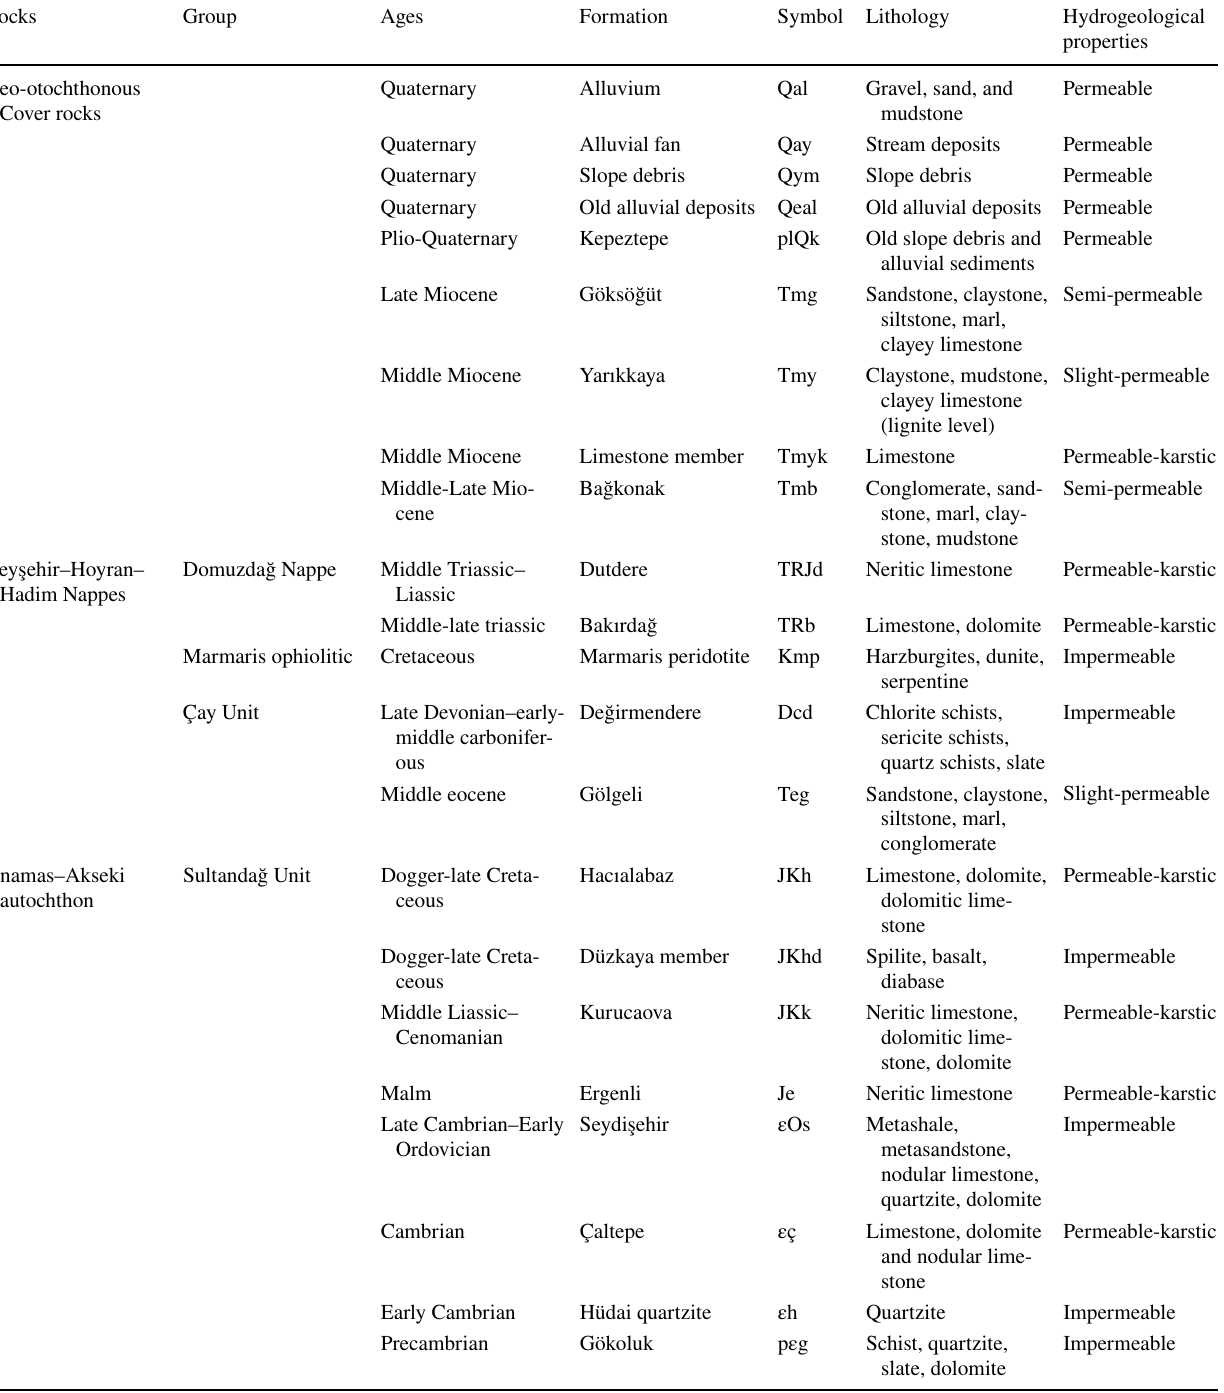
Table 1 The lithological and hydrogeological properties of stratigraphic units